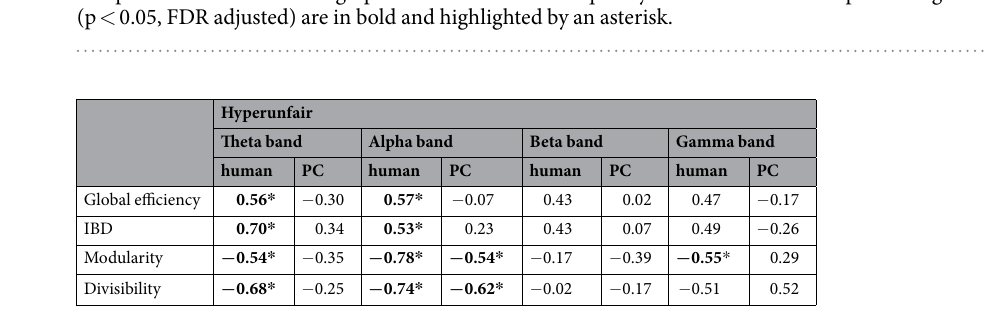
Table 2. Statistical regression between punishment score and graph theory indices during hyperunfair condition. Significant correlations are highlighted in bold and denoted by an asterisk (p < 0.05 corrected by